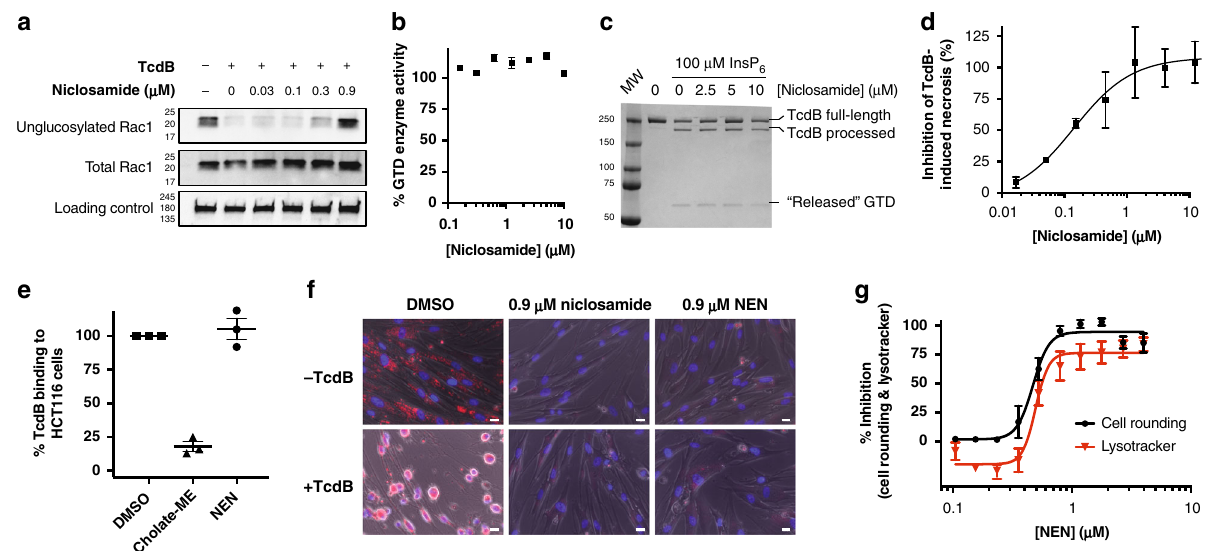
Fig. 2 Mechanism-of-action of niclosamide inhibition of TcdB intoxication. a Western blot image for intracellular Rac1 glucosylation ( n = 3). IMR-90 cells were treated with niclosamide (doses indicated) for 15 min, followed by treatment with 0.5 pM TcdB. Cells were harvested as described in Methods. Mab102, which recognizes un-glucosylated Rac1 in cells, shows a dose-dependent re-appearance with increasing concentration of niclosamide, relative to total Rac1 levels ( n = 2). b In vitro GTD glucosyltransferase assay. Recombinant GTD was incubated for 30 min with different doses of niclosamide ( n = 3). Activity was measured as described in Methods. Niclosamide at concentrations up to 10 μ M did not directly affect GTD activity itself. c In vitro auto- processing assay. Compound or DMSO was added to 100 nM TcdB, and pre-incubated for 60 min. To initiate auto-processing, InsP6 was added (100 μ M) and incubated @ 37 °C for 20 min before stopping with Laemlii sample buffer. Niclosamide at concentrations up to 10 μ M did not affect auto-processing ( n = 2). d Niclosamide was titrated in IMR90 cells in the presence of 1 nM TcdB for 3-h. Loss of cellular ATP as a marker of high dose toxicity was measured by adding CellTiter-Glo reagent (Promega). Niclosamide inhibited TcdB-induced necrosis with an IC 50 = 0.15 μ M. Bars represent SEM of two experiments. e Cell surface binding assay was carried out as described in Methods. Methylcholate, but not NEN, prevented surface binding of TcdB to cells TcdB. Acidic compartments are stained in red, while the nuclei are stained in blue. Cells treated with TcdB and vehicle are rounded and raised in comparison to untreated cells. Cells treated with niclosamide or NEN did not exhibit LysoTracker staining, and were protected from TcdB-induced cell